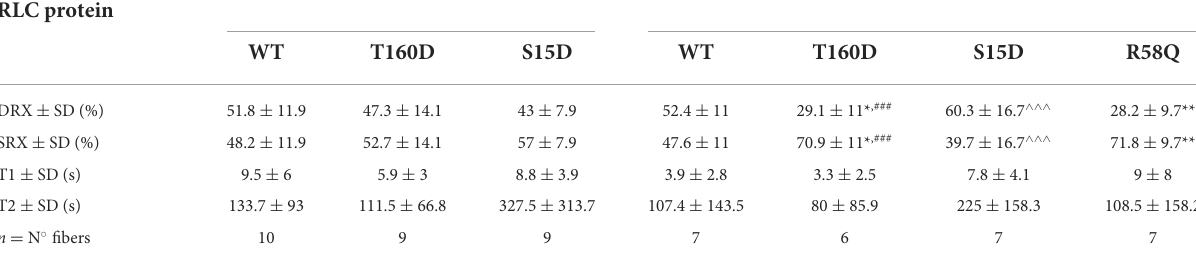
TABLE 4 The SRX state of myosin measured by mant-ATP/ATP chase assays in skinned LVPM from Tg-WT and Tg-R58Q mice reconstituted with recombinant RLCs proteins. Parameter/recombinant LVPM from Tg-WT mice LVPM from Tg-R58Q RLC protein